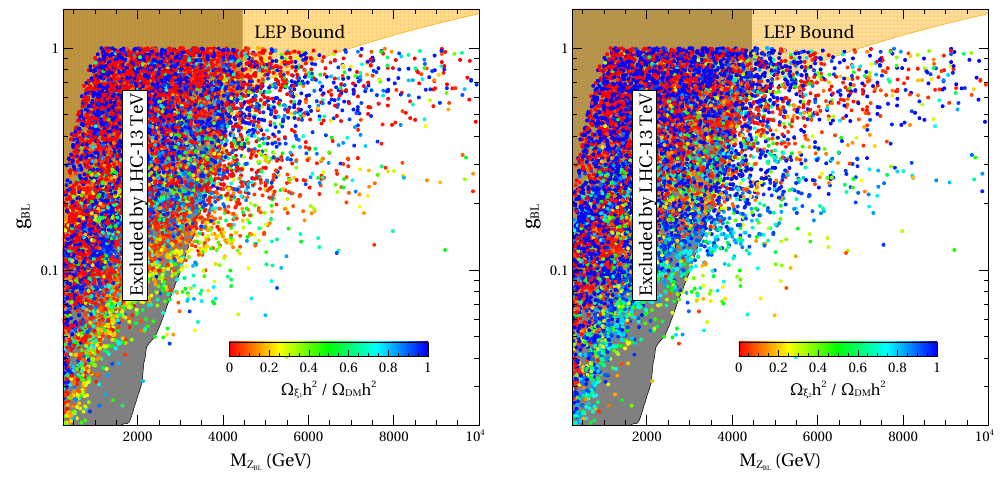
Figure 8 . Scan plot showing the parameter space in g BL relic abundance, perturbativity, bounded from below criteria of the scalar